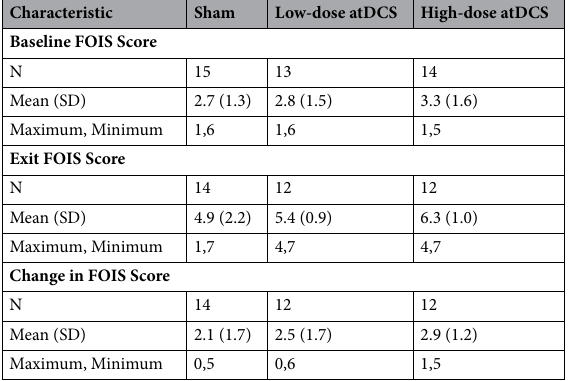
Table 4. Dietary outcome-intent to treat analysis. Changes in the functional oral intake scale (FOIS) scores across sham and anodal transcranial direct stimulation (atDCS)